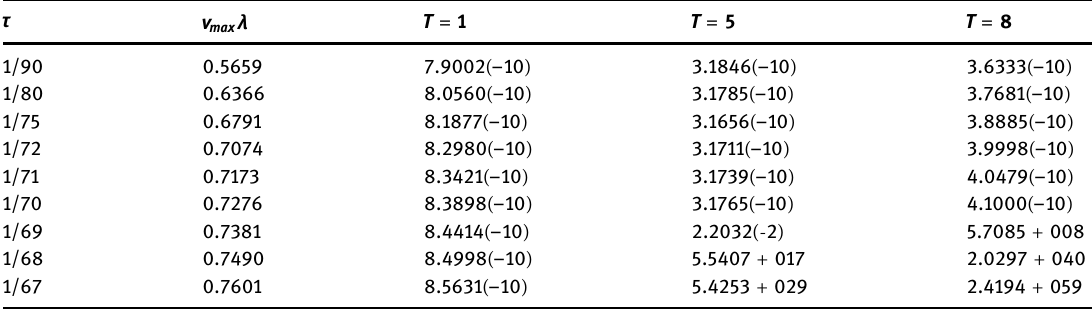
Table 10: When = / h π 80 for di ff erent T and τ , the L ∞ error for Example